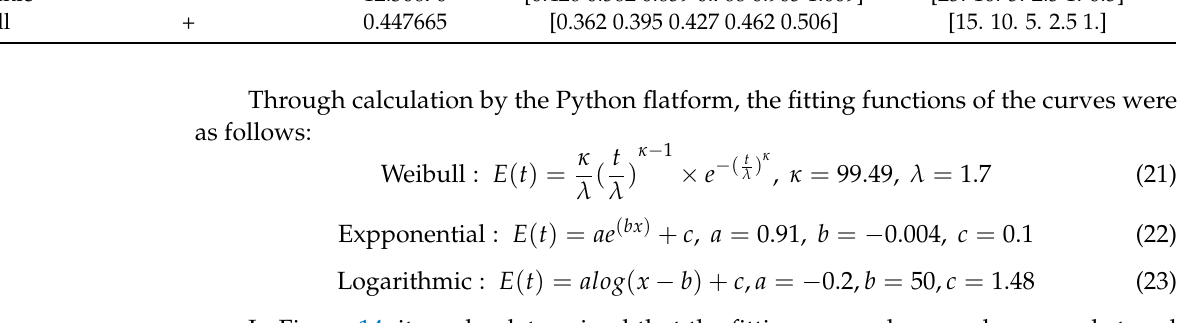
Table 11. Test results of three curve shape fitting.